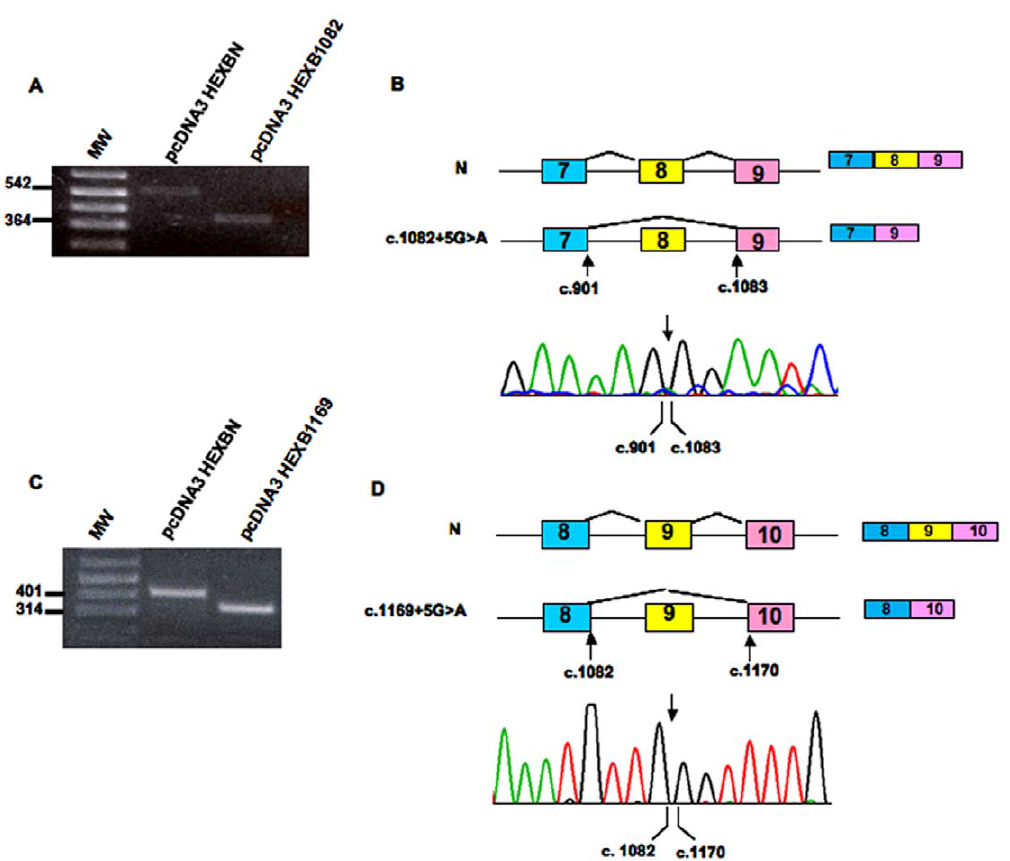
Figure 4. Invitro functional analysis of mutations c.1082 + 5G . A and c.1169 + 5G . A. RT-PCR analysis of the HEXB mRNA in cells transfected with normal (pcDNA3HEXBN) and minigenes containing mutations c.1082 + 5G . A (pcDNA3HEX1082) and c.1169 + 5G . A (pcDNA3HEX1169) (panels A and C, respectively). MW: 1 kb Plus DNA Ladder. Schematic representation of the effect of the novel mutations on the splicing process (panels B and D). Sequencing analysis of RT-PCR products showed that the c.1082 + 5G . A mutation determines the skipping of 178 nt of exon 8 (panel B), whereas the presence of c.1169 + 5G . A mutation determines the retention of 87 nt of exon 9 (panel D).